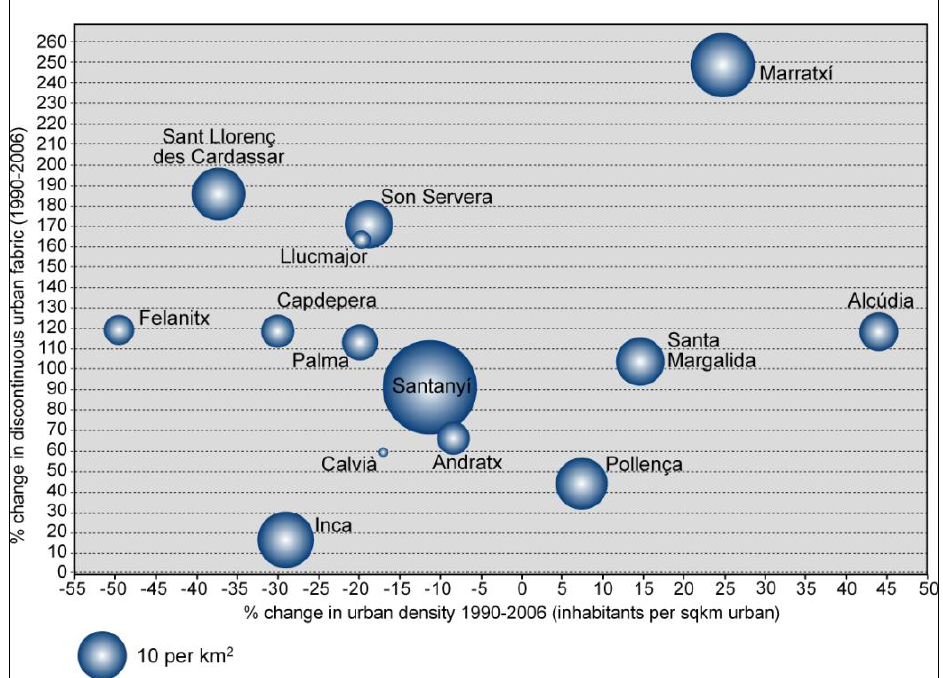
Figure 4. Exurban swimming pool density (radius of the bubble) plotted against change (1990–2006) in discontinuous urban fabric (y-axis) and change in urban density (x-axis) in selected municipalities in Majorca. Data source: Own calculations based on 1:5,000 Topographic Map of the Balearic Islands, 2006, and